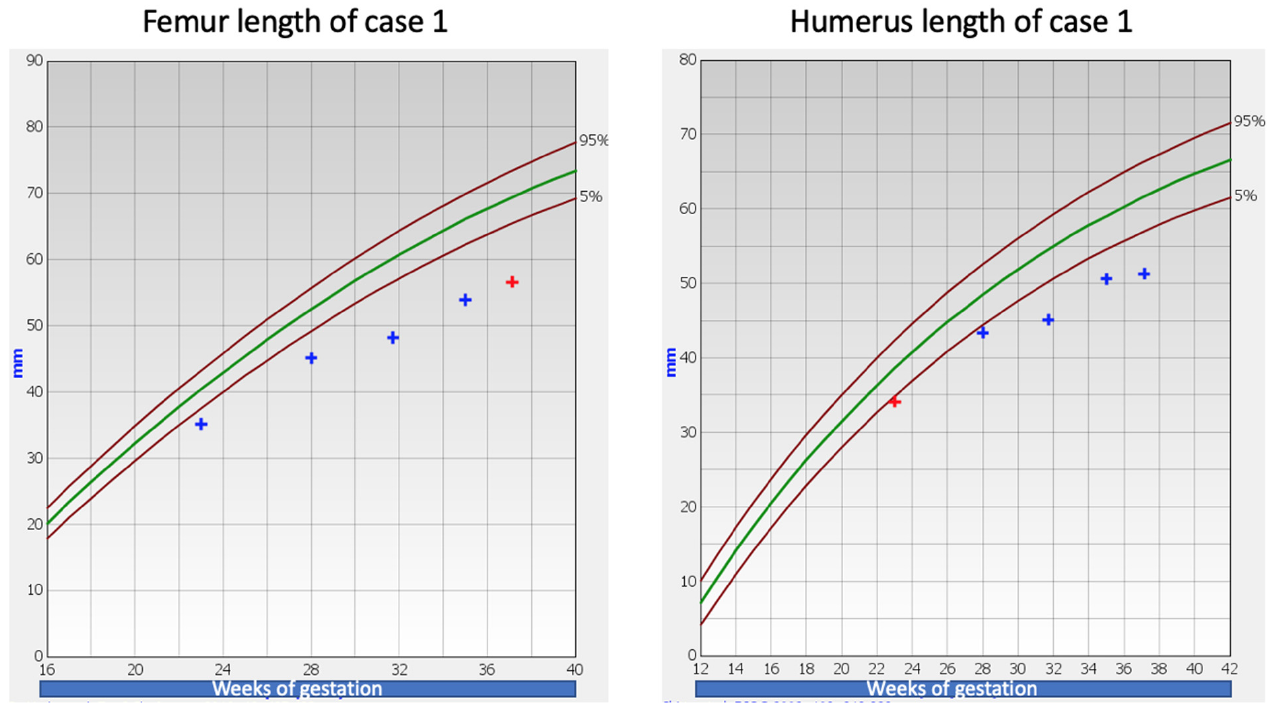
Figure 1. Femur and humerus length of Case 1 [3,4]. The green line represents the 50 th